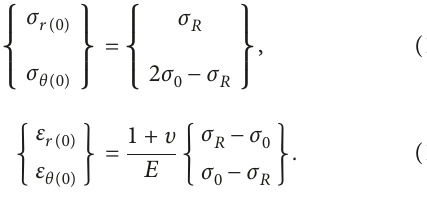
Figure 2: Evolution of parameters in plastic circles of normalized radii r r R / R p in Figure 3. The thickness of each annulus is i i ( ) (cid:31) ( ) not uniform in general. On the outer boundary of plastic zone, where r 1, stress and strain components under 0 ( ) (cid:31) plane strain condition are obtained from Equations (14) and (15).